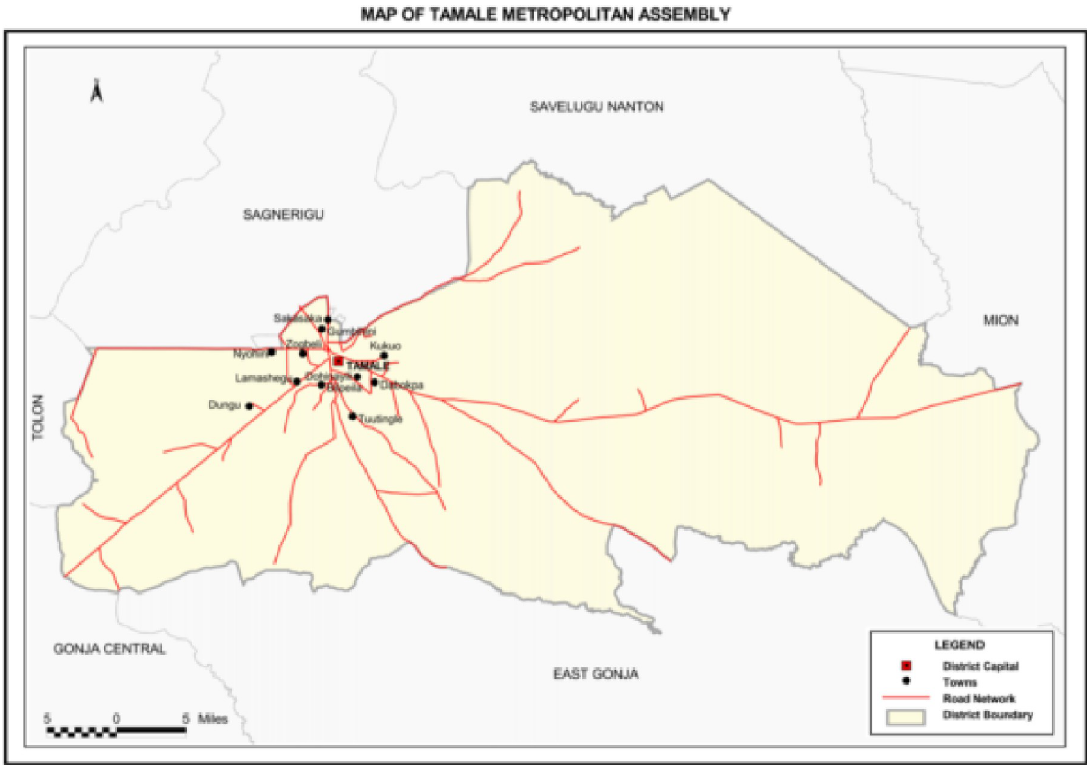
Fig 1. Showing the map of Tamale in the Northern region of